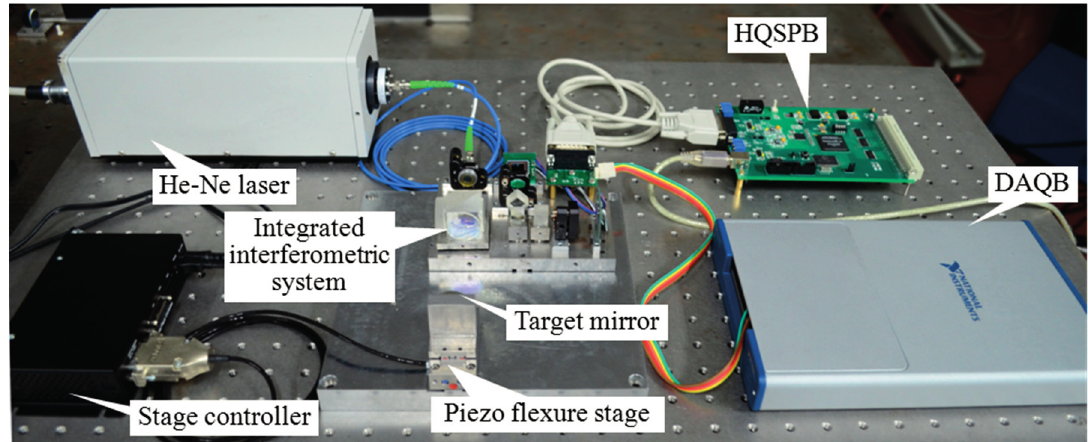
Figure 12. Experimental setup for the compensation of cyclic